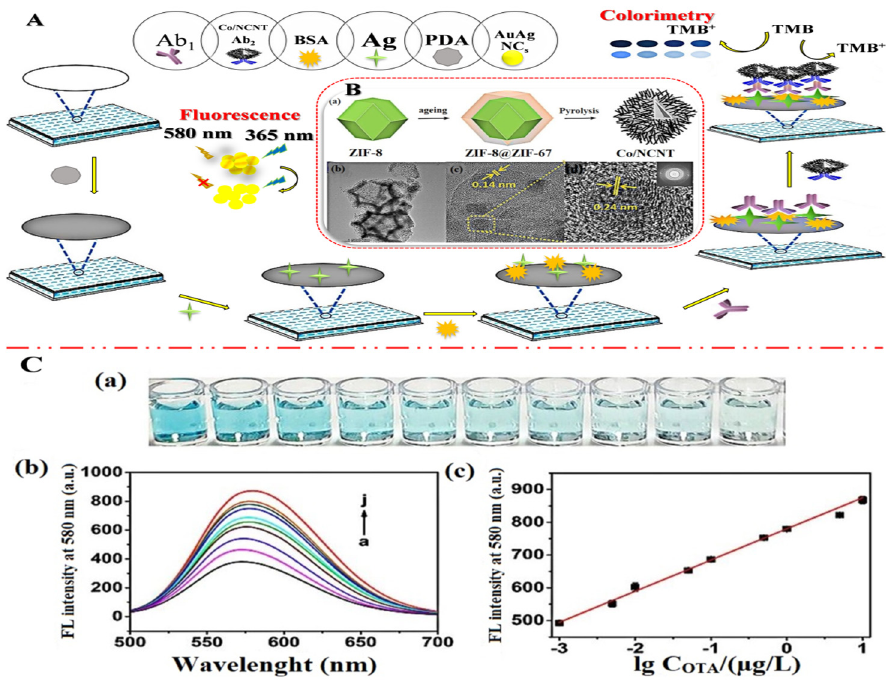
Figure 7. ( A ) Diagrammatic representation of a dual-mode immunosensor that mimics oxidase utilizing Co/NCNT: ( B ) (a) The Co/NCNT synthesis method; the low-resolution (b) and (c and d) high-resolution TEM pictures, as well as the matching electron diffraction images (illustration of d), EDS; ( C ) (a) colorimetric photos, (b) fluorescence spectroscopy, and (c) ochratoxin A (OTA) calibration plot with various concentrations (a–j: 0, 0.001, 0.005, 0.01, 0.05, 0.1, 0.5, 1, 5, 10 μ g/L). Adapted with permission from the article [70]. 2022, Elsevier.